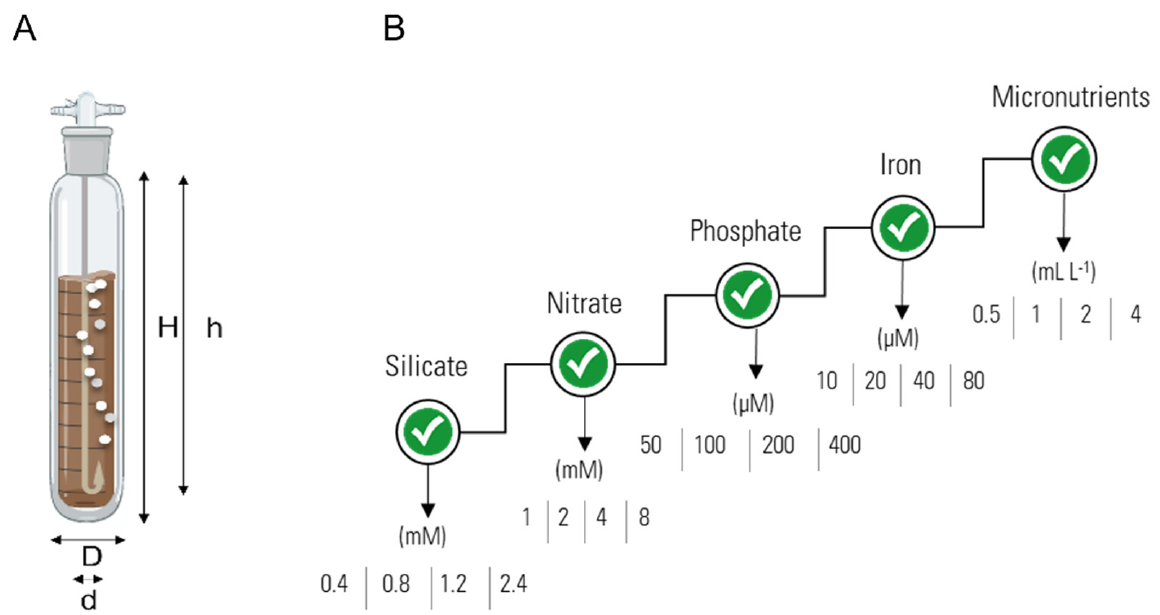
Figure 1. ( A ) schematic representation and dimensions of the bubble columns PBRs system